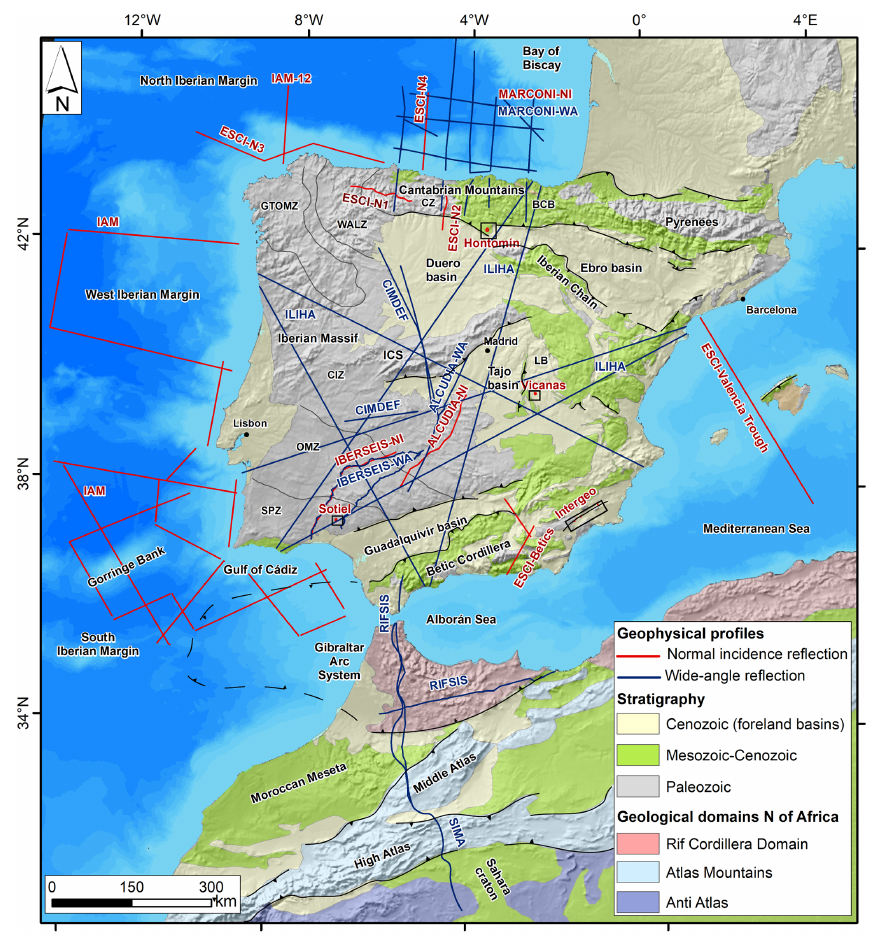
Figure 3. Geological map of the Iberian Peninsula and north of Africa with the seismic profiles provided in SeisDARE. The geological units are simplified from the IGME Geological Map of the Iberian Peninsula 1 : 1000000 (Rodríguez Fernández et al., 2014) and the bathymetry and topography from OpenTopography (Ryan et al., 2009) and Natural Earth. Note that the MARCONI offshore experiment acquired simultaneously normal incidence and wide-angle reflection, whereas on land, only wide-angle data were acquired. BCB: Basque- Cantabrian basin; CZ: Cantabrian Zone; WALZ: West Asturian-Leonese Zone; GTOMZ: Galicia-Trás-Os-Montes Zone; CIZ: Central Iberian Zone; OMZ: Ossa Morena Zone; SPZ: South Portuguese Zone; ICS: Iberian Central System; LR: Loranca